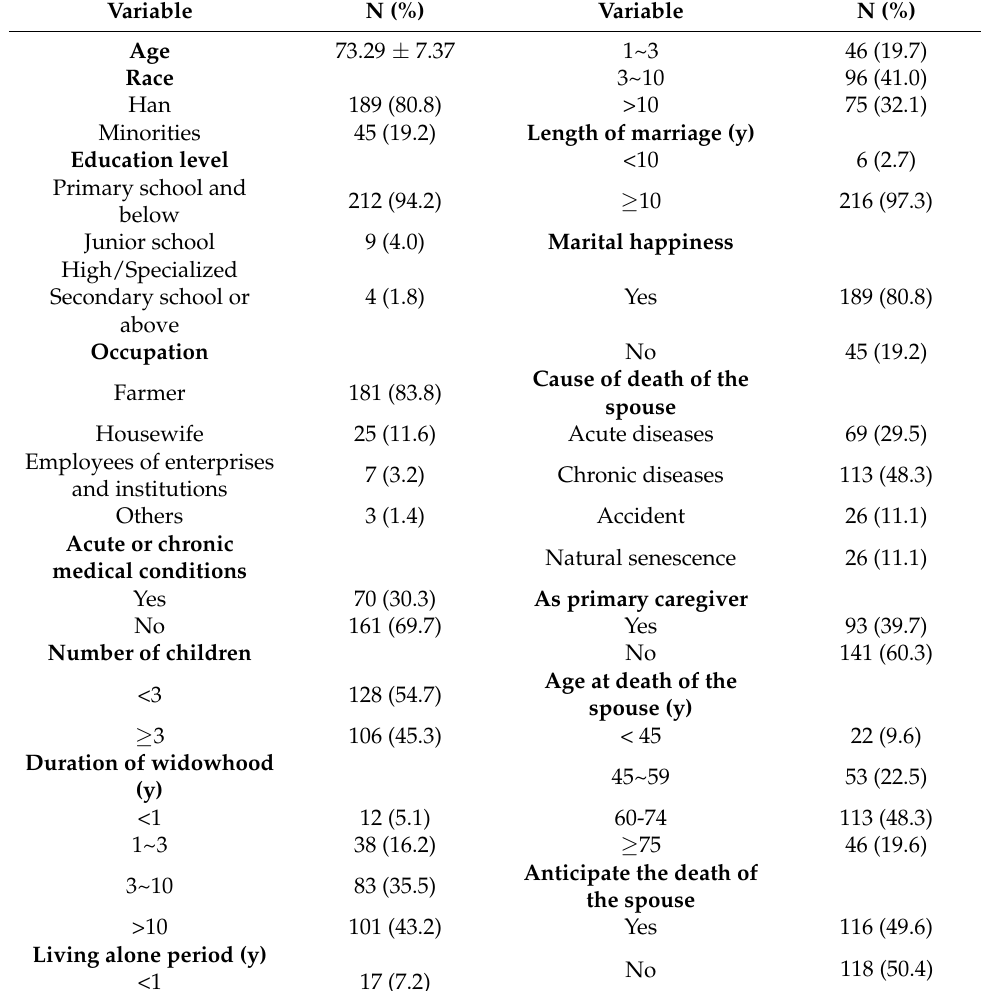
Table 1. Demographic characteristics of the remote elderly widows living alone (N = 234, % or mean ±